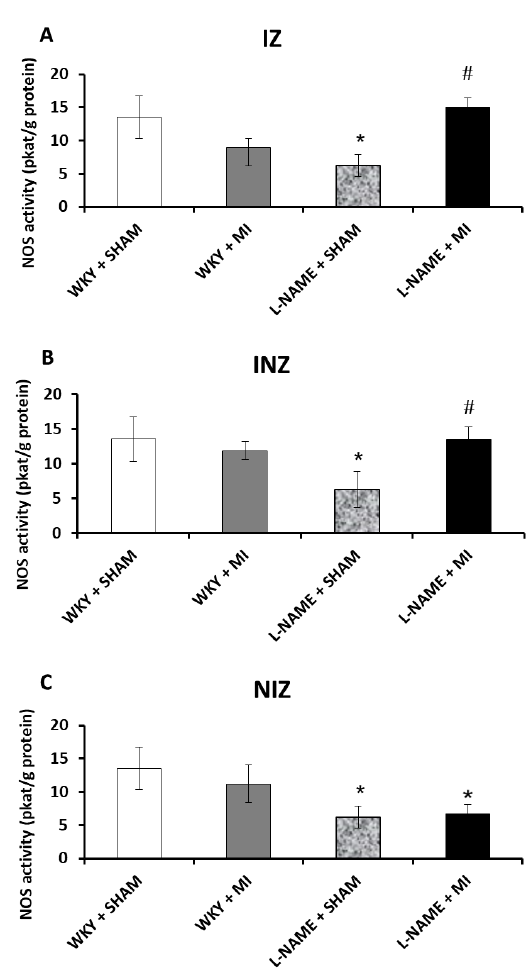
Figure 1. The effect of myocardial infarction on nitric oxide synthase (NOS) activity of infarcted zone (A), injured zone (B) and non-infarcted zone (C) of myocardium . Total NOS activity levels of sham operated Wistar Kyoto rats (WKY + Sham); WKY rats with experimentally induced myocardial infarction (WKY + MI); sham operated WKY rats treated with L-NAME (20 mg/kg/day) (L-NAME + Sham) and L-NAME (20 mg/kg/day) treated WKY rats with experimentally induced myocardial infarction (L-NAME + MI) in infarcted zone (IZ) (A), injured zone (INZ) (B) and non-infarcted zone (NIZ) (C). * p < 0.05 compared to WKY + Sham; # p < 0.05 compared to L-NAME + Sham group; N = 6 in each group.